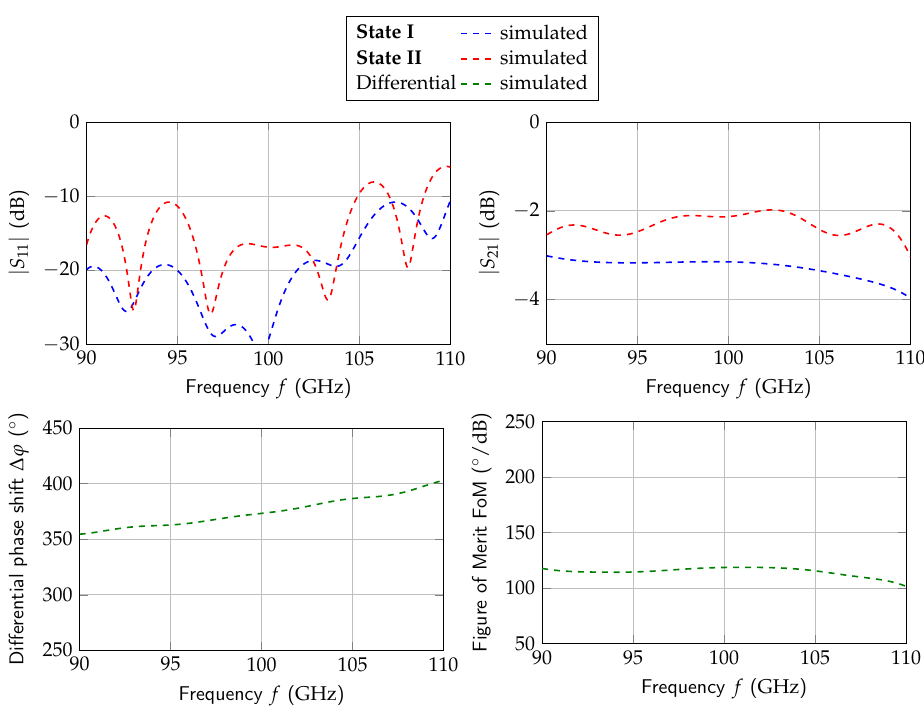
Figure 20. Microscopic view on an evaporated as well as photolithographically processed Chromium electrode on a 20µm thick PET substrate.